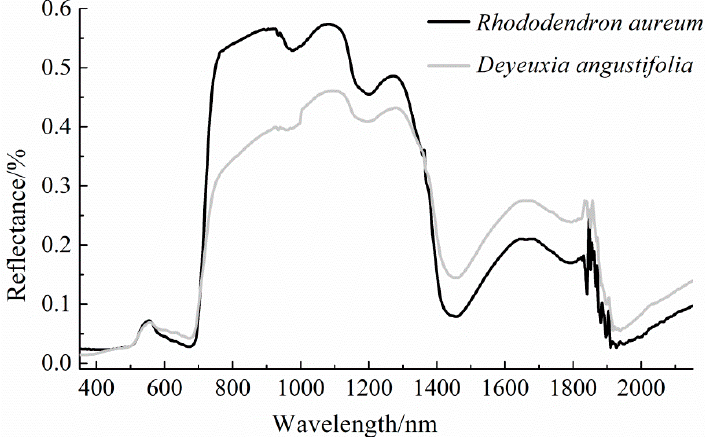
Figure 4. Reflectance curves of R. aureum and Deyeuxia angustifolia at the senescence periods. Through overlaying the distribution of R. aureum and volcanic ashes (Figure 3b) on the Landsat image acquired on 5 October 2017 nearest in time to the GF-2 image, we found that Landsat NDVI values indicating areas of pure R. aureum (>80% of pixels covered by R. aureum ) were greater than 0.2